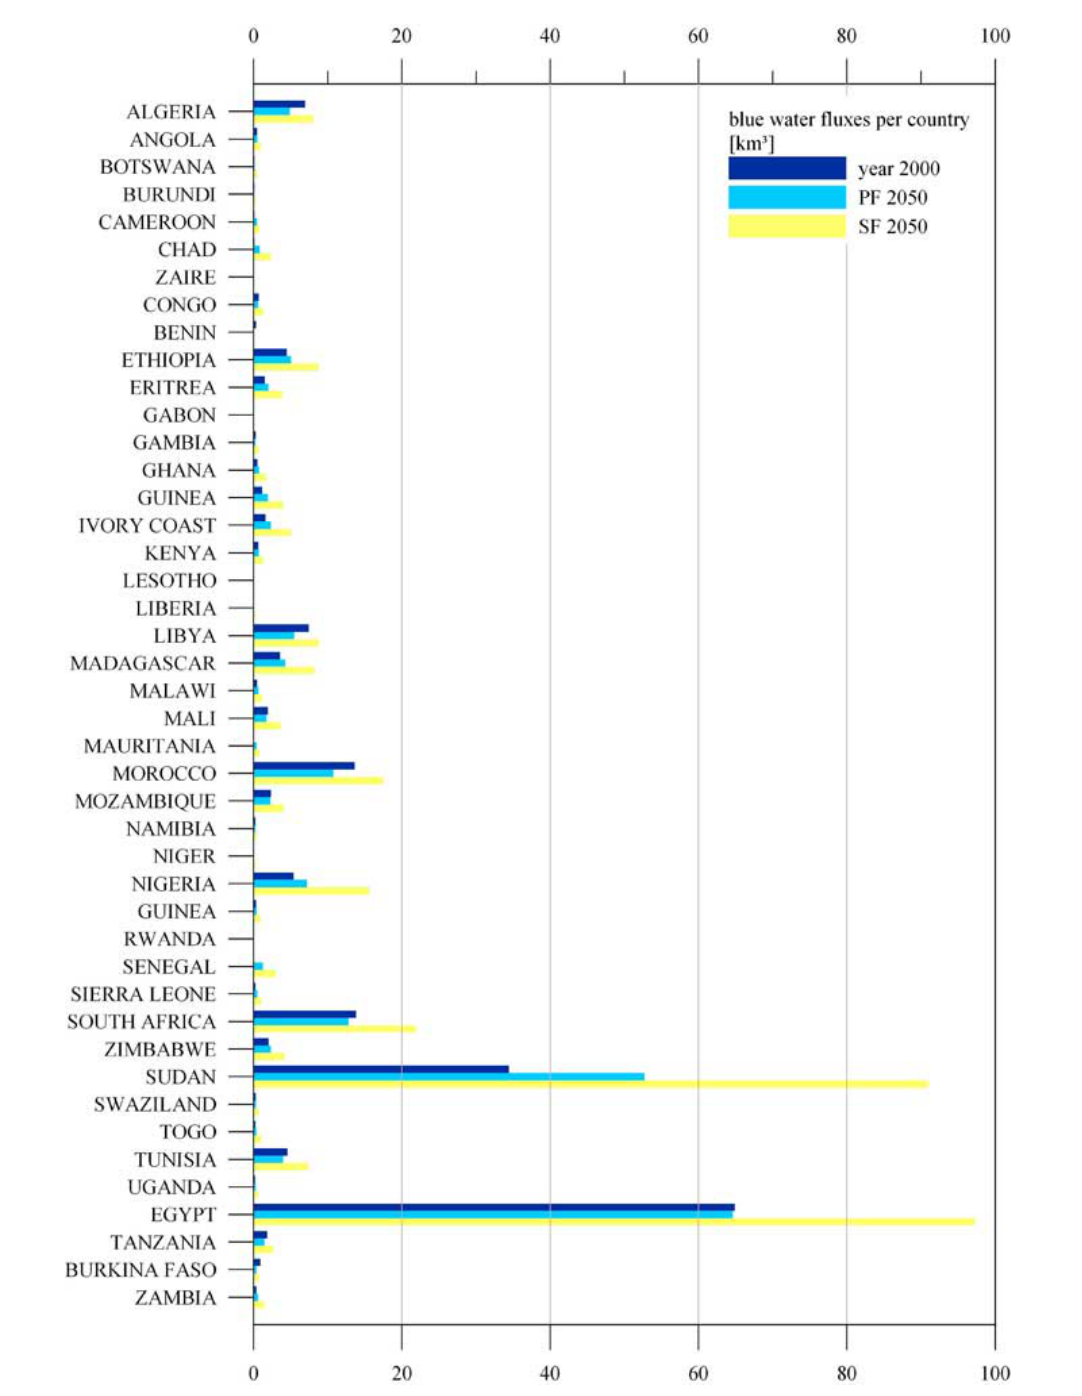
Figure 7. Country-level crop-related part of blue water fluxes (irrigation withdrawals) for the year 2000, and for the “Policy First” and “Security First” scenarios for